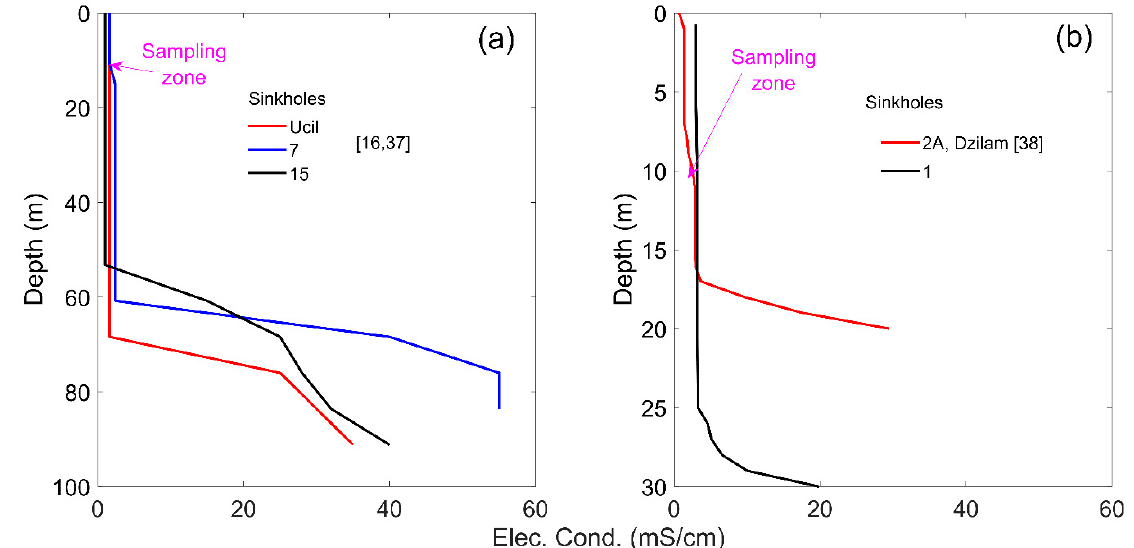
Figure 2. Specific conductivity vs. depth in ( a ) sinkholes in R and MD zone (it can consult original data in reference [16,37]), ( b ) sinkhole 1 and one well in coastal zone Dzilam (2A, [38]). The numbers 1, 7 and 15 represent sinkholes in this study; data from sinkhole 1 were recorded in March 2007.